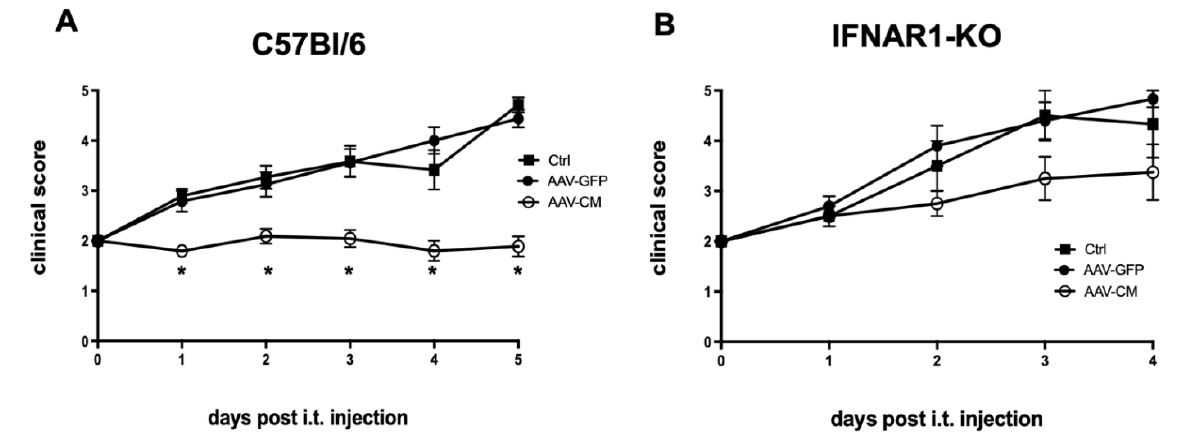
Figure 3. Intrathecal AAV-CM suppressed EAE in an IFNAR-dependent manner. C57BL/6 or IFNAR1-deficient mice were immunized with MOGp35–55 to induce EAE and at disease onset, they received intrathecal AAV-CM, AAV-GFP or PBS, and clinical signs were scored daily. ( A ) Mice that received AAV-CM showed marked attenuation of the disease compared to the control mice. Sick mice treated with intrathecal AAV-GFP showed similar symptoms to those in PBS-treated mice ( n = 12–22 in each group). The data were pooled from three independent studies. ( B ) The protective effect of intrathecal AAV-CM was abrogated in IFNAR1-KO mice. ( n = 4–5 per group). Data are presented as mean ± SEM. The results were analyzed using the two-tailed Mann–Whitney u-test. * p < 0.05.